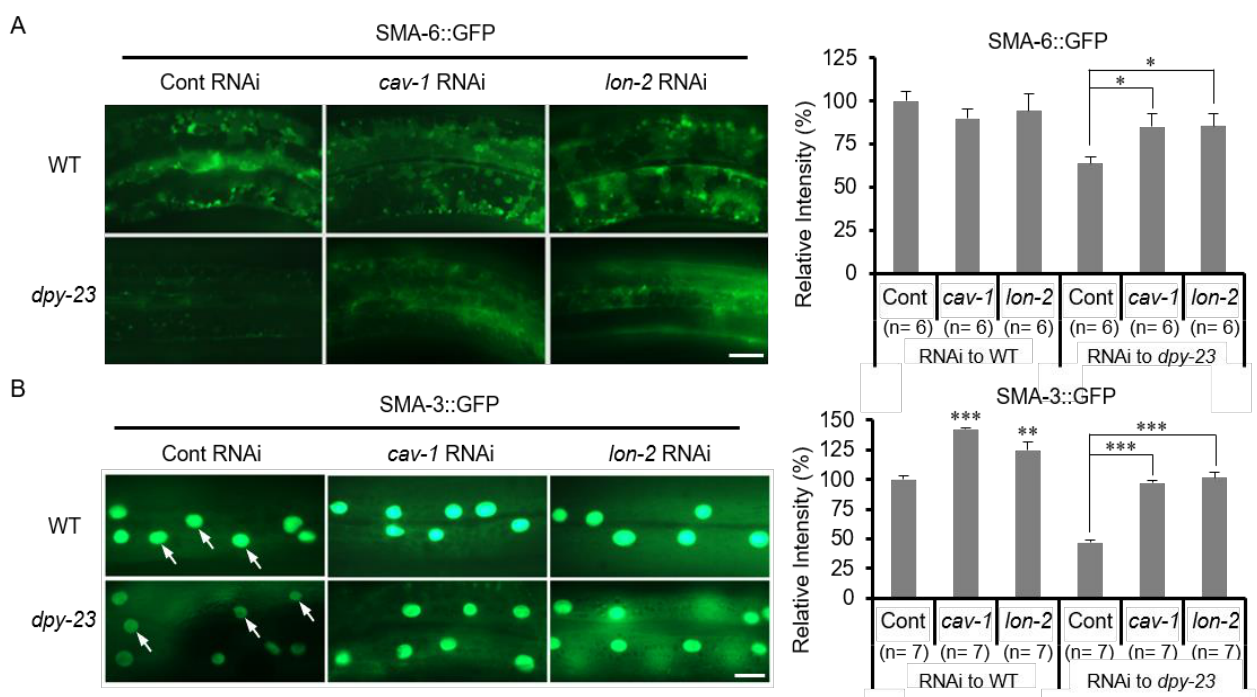
Figure 4. TGF- β signaling in the dpy-23 mutant. The expression level of SMA-6/TGF- β receptor I (T β RI) and SMA-3/R- Smad in the dpy-23 mutant compared to the wild type using SMA-6::GFP and SMA-3::GFP expressed in the hypodermis by Y37A1B.5 p . The transgenic worms expressing SMA-6::GFP ( A ) and SMA-3::GFP ( B ) in the wild type and the dpy-23 mutant were treated with cav-1 and lon-2 RNAi to examine the change of TGF- β signals. The fluorescence intensity of SMA-6::GFP and SMA-3::GFP was measured and shown graphically in the right panel of each figure. In case of SMA-3::GFP quantification, nuclear localized SMA-3::GFP was measured in contrast to SMA-6::GFP, which is measured with total GFP. Arrows indicate nuclei of hypodermal cells. Scale bar = 10 µ m. Error bar = SEM. * p < 0.05, ** p < 0.01 and *** p < 0.001 versus Cont.